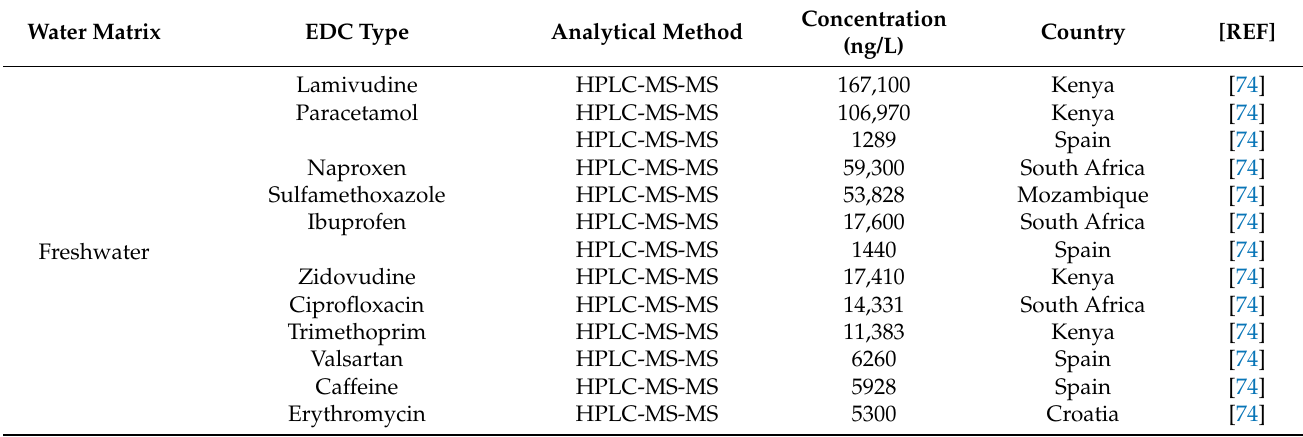
Table 1. Concentrations of main EDCs in different water